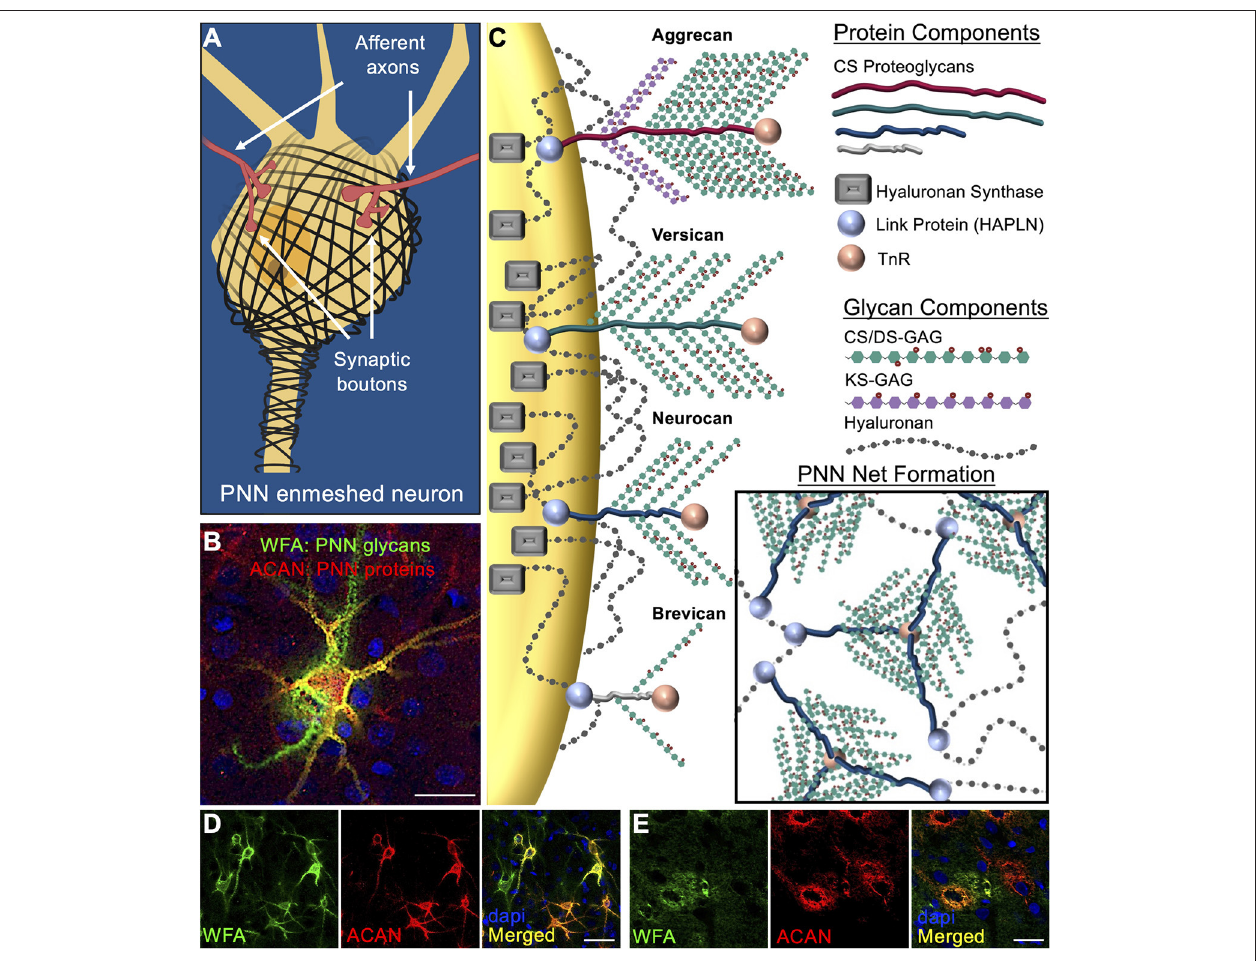
FIGURE 1 | Perineuronal net composition and structure. (A) PNNs enmesh the soma and proximal axons and dendrites of target neurons (see Logsdon et al., 2021). Synaptic contacts between pre- and post- synaptic neurons are dynamically regulated by gaps formed in the PNN lattice. (B) Visualization of brain PNNs is possible by antibody labeling of the underlying CSPG core protein (aggrecan, red ) and lectin labeling of the attached CS-GAGs (WFA, green ) (rat motor cortex show) (see Alonge et al., 2020). (C) PNN matrices are primarily comprised of the lectin family of CSPG core proteins (e.g., aggrecan, versican, neurocan, and brevican). Link proteins attach the CSPGs to the underlying hyaluronan (HA) glycans, which are then anchored to the neuronal cell surface by hyaluronan synthase (HAS) proteins. PNN net formation occurs through tri-linkages between CSPGs and Tenascin R (TnR) glycoproteins in the extracellular space. PNNs in rat (D) visual cortex exhibits intricate, lattice-like formations surrounding the neuronal soma and extending processes of the enmeshed neuron, while rat (E) hypothalamus shows diffuse, unstructured matrix formation (see Alonge et al., 2020). PNN populations in both the cortex and hypothalamus exhibit heterogenous composition that includes WFA + /aggrecan + , WFA + /aggrecan − , and WFA − /aggrecan + PNN substructures. Scale bar: (B,E) 25 µ m, (D) 50 µ m. WFA, Wisteria floribunda agglutinin; ACAN, aggrecan; PNN, perineuronal net; CS/DS-GAGs, chondroitin/dermatan sulfate-glycosaminoglycans; TnR,